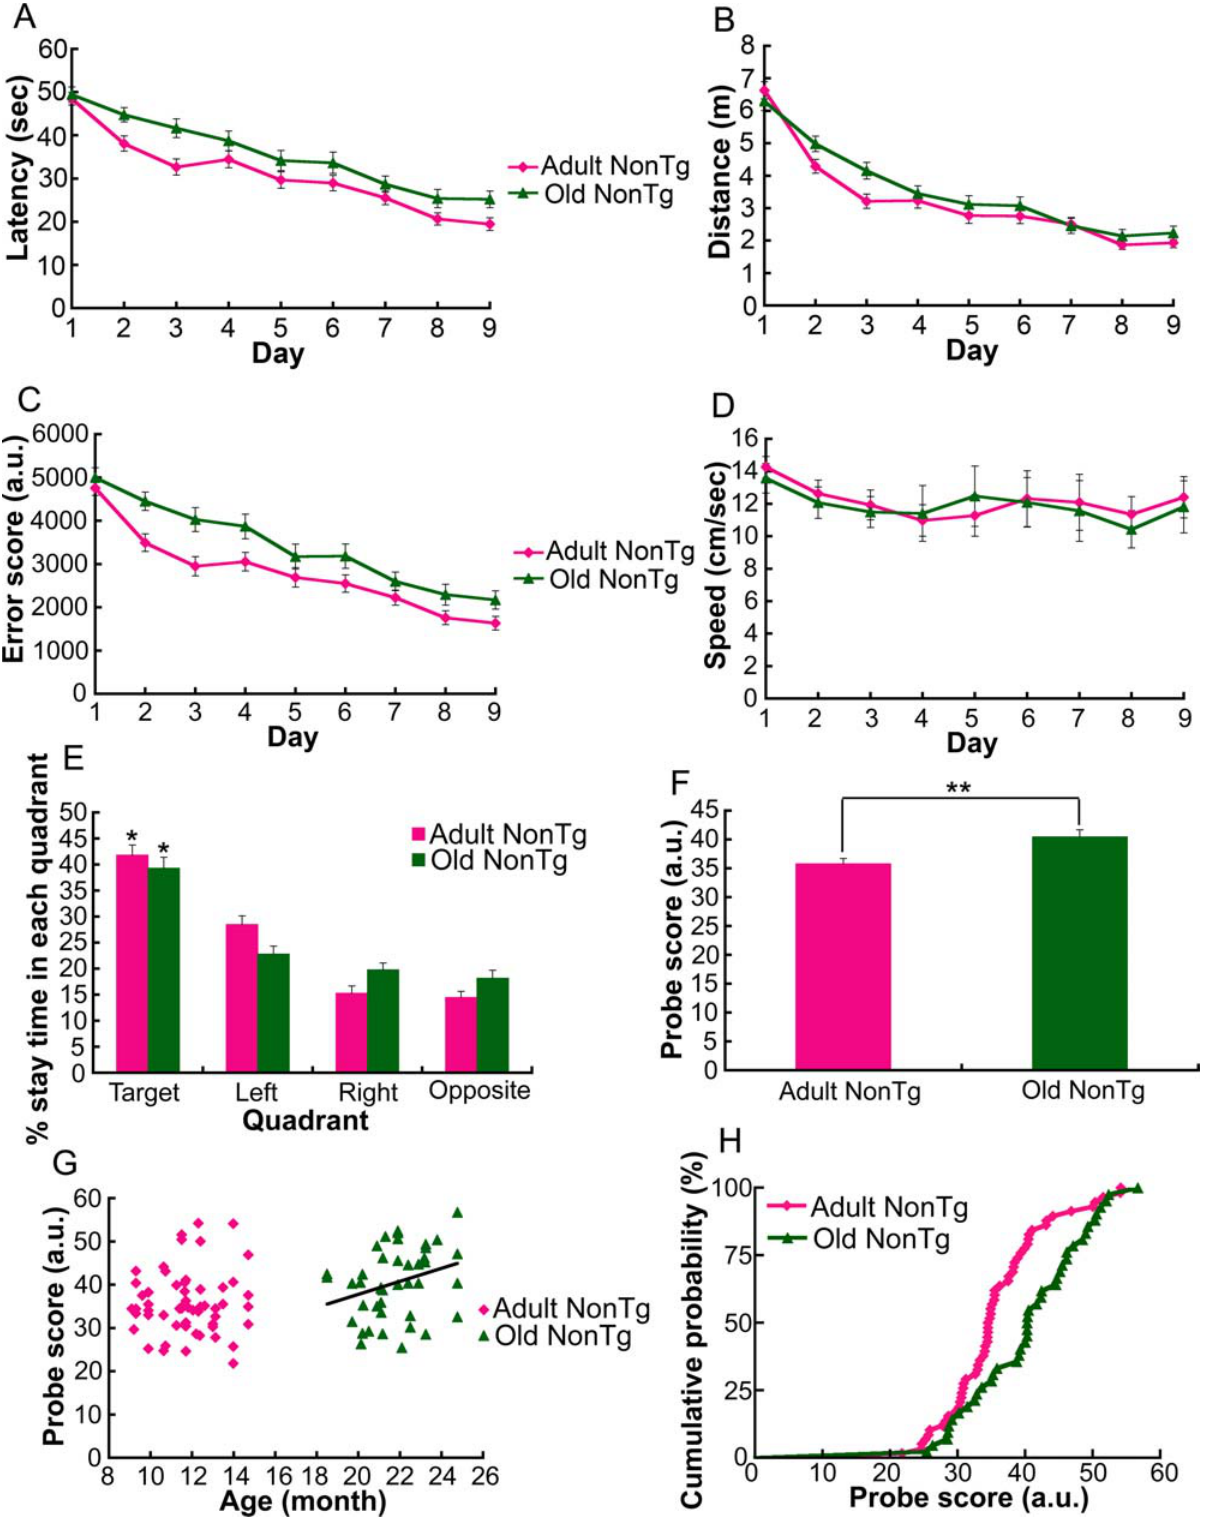
Figure 2. Age-dependent delay in learning and reduced accuracy of memory in wild-type mice. (A) Old nonTg mice took significantly longer than adult nonTg mice to reach the hidden platform (F[1,98]=5.74, p=0.0167; repeated measures two-way ANOVA). (B) There was no statistical difference in the distances swam by mice of the two age groups. (C) The error scores of old nonTg mice were significantly higher than those of adult nonTg mice (F[1,98]=11.42, p=0.0008; repeated measures two-way ANOVA). (D) The swimming speed of mice of the two age groups was not significantly different. (E) Both adult and old nonTg mice displayed a place preference for the target quadrant in the probe test (both age groups, *p , 0.0001; Friedman test). There was no statistical difference in the percentage dwell time in the target quadrant of adult and old nonTg mice. (F)